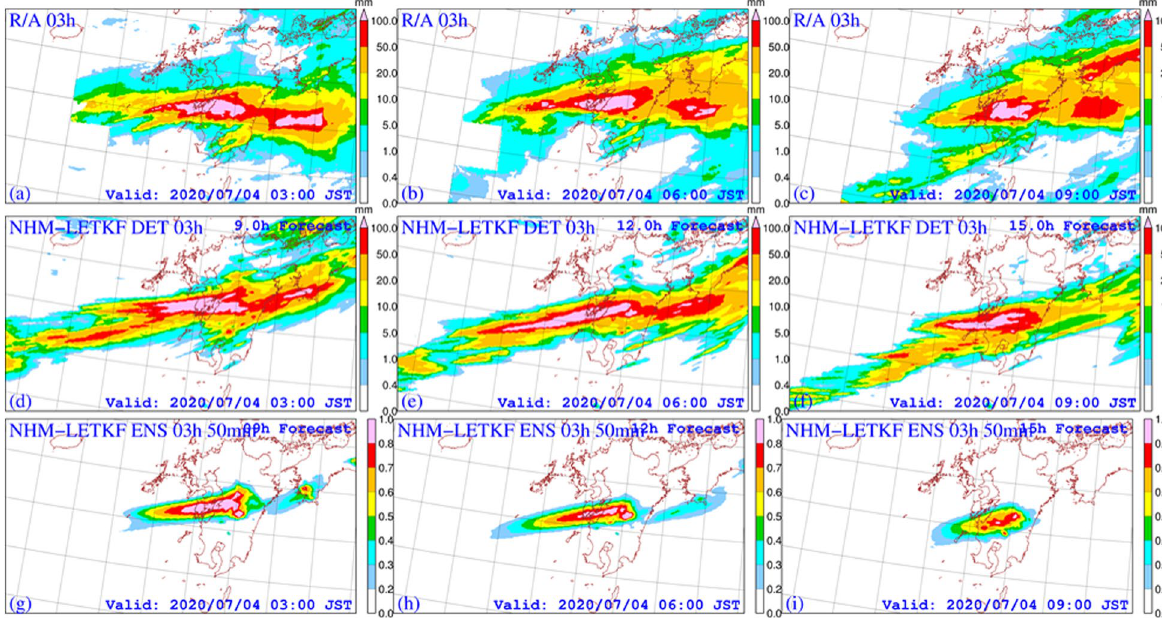
Fig. 1 a , b , c Observations of consecutive 3-h precipitations between 00 and 09 JST July 4th 2020. d , e , f The corresponding 2-km forecasts by NHM-LETKF started at 18 JST July 4th 2020. g , h , i The corresponding 2-km probabilistic forecasts with respect to a rainfall threshold of 50 mm/3 h. (Reproduced Duc et al. 2021)